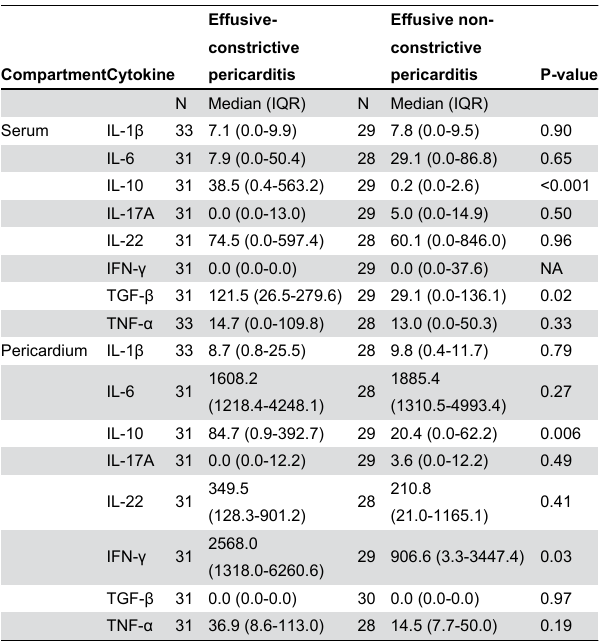
Table 2. Serum and pericardial cell-free fluid levels of cytokines at baseline in patients with tuberculous effusive constrictive and effusive non-constrictive pericardial disease (all values in